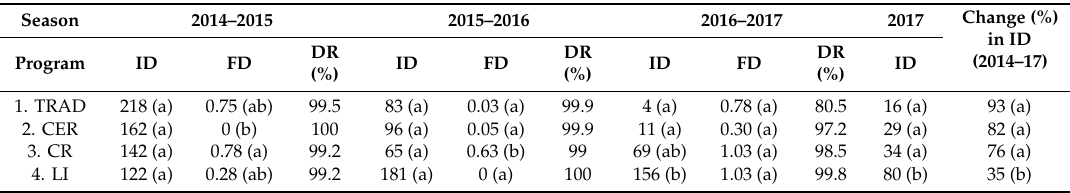
Table 2. Initial (ID) and final (FD) Papaver rhoeas density means (plants m − 2 ) under di ff erent management programs during three consecutive seasons. DR: annual reduction in density, FD relative to ID in %. Last column represents the reduction of ID in December